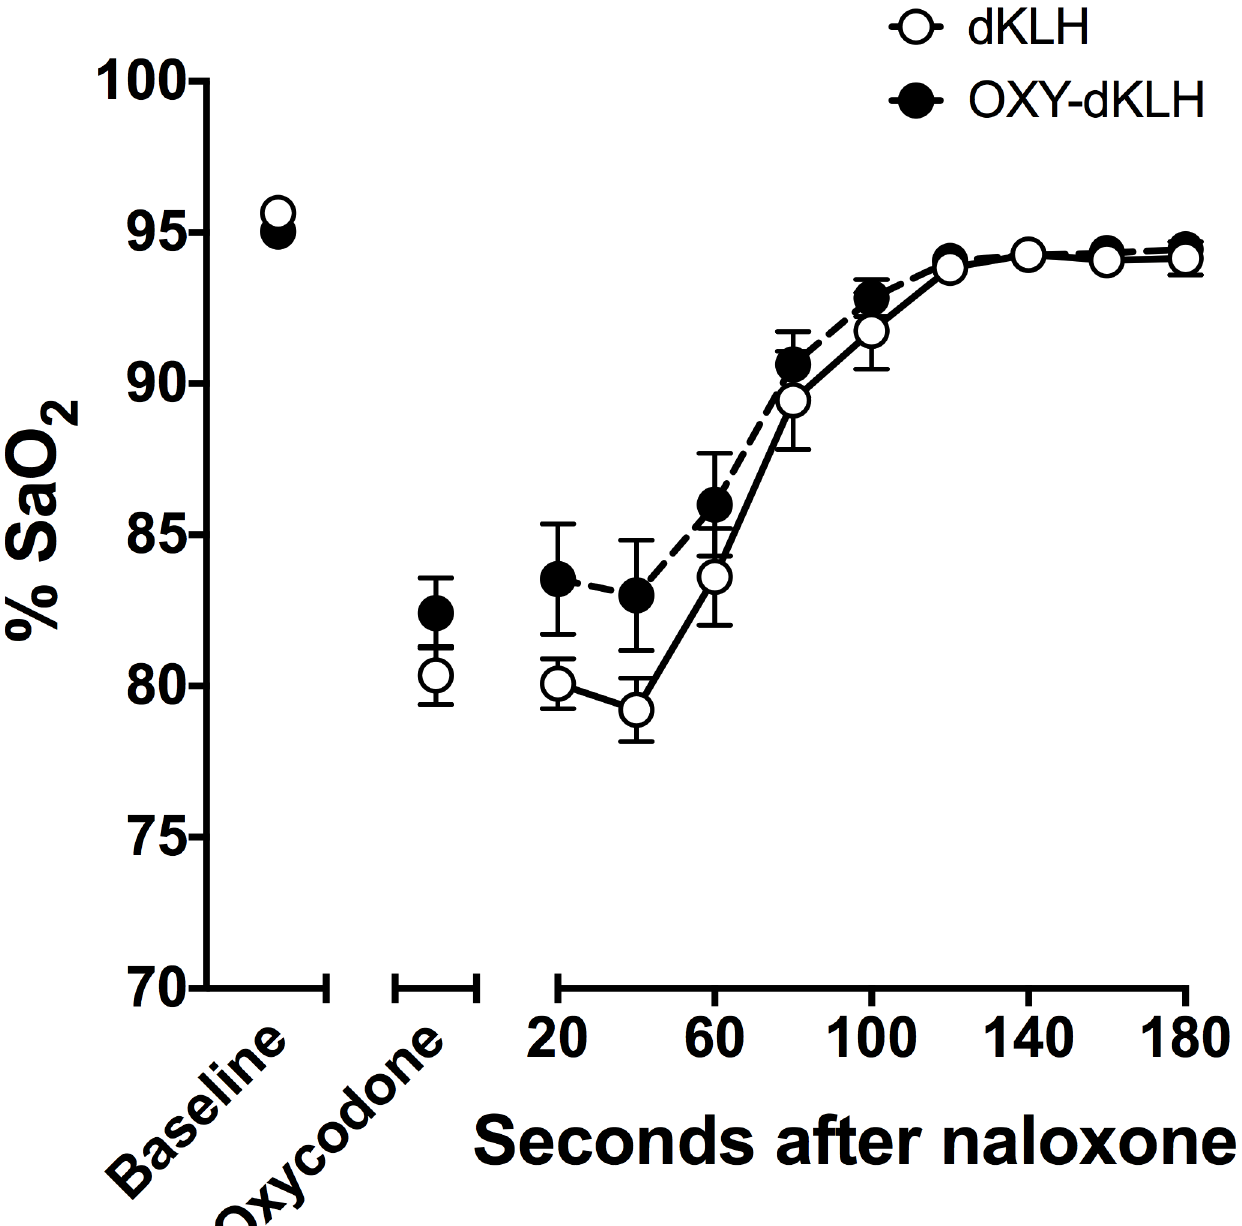
Fig 2. Naloxone reverses oxycodone-induced respiratory depression in vaccinated animals. Naloxone0.1 mg/kg s.c. was administered to mice 30 minutes after oxycodone9.0 mg/kg s.c. SaO 2 recoveredpromptly in both OXY-dKLH and control groups. SaO 2 did not differ between OXY-dKLH and control groupsat any time after naloxonetreatment (p = 0.65). Mean ± SEM; n = 11 for KLH and n = 12 for OXY-KLH.